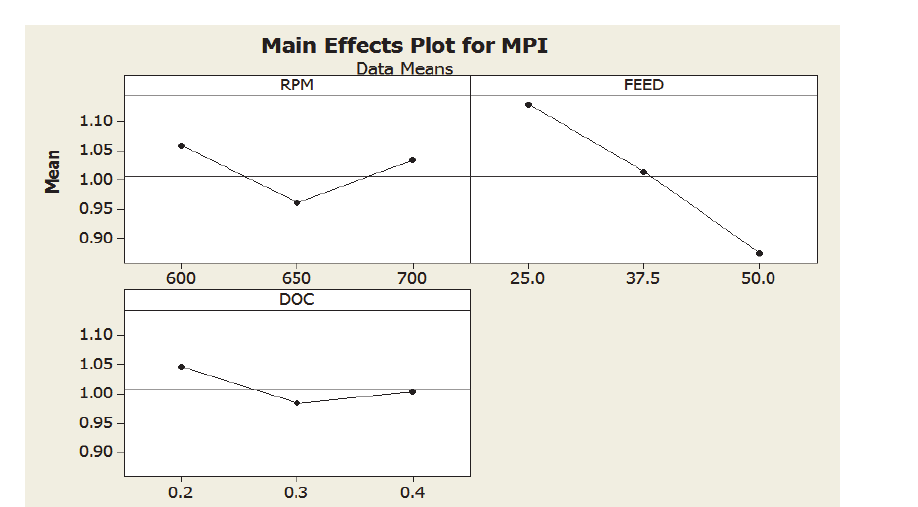
Fig. 12. Main effects plot for